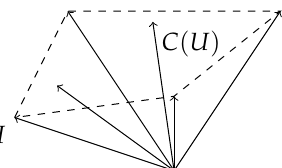
Figure 2. Set of vectors U and its convex vector subspace C ( U ) in R 2